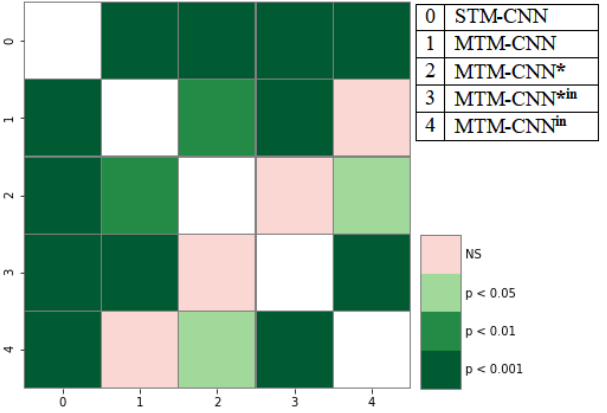
Figure 7. Post hoc pairwise analysis of Friedman’s test for the MTM-CNN.